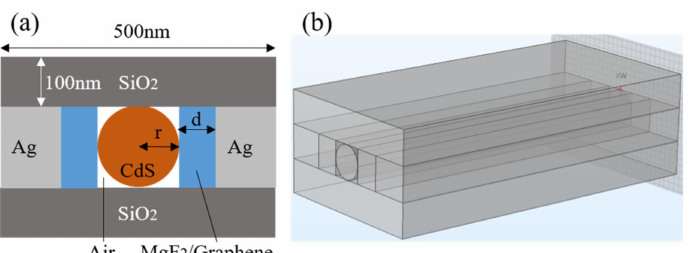
Figure 1. ( a ) The two-dimensional profile and ( b ) the three-dimensional geometry of waveguide model. The structure is composed of CdS gain medium nanowires, an upper SiO 2 layer, a lower SiO 2 layer, left and right medium layers and Ag layers, and an air gap area. Here, the dielectric layer thickness is d and the radius of the CdS nanowires is r . Based on the actual value synthesized in the laboratory and the difficulty of the simulation, the laser length L is set at 10 µ m. The dielectric constants of CdS, MgF 2 , and SiO 2 are 5.76, 1.96, and 2.18, respectively. The dielectric constants of graphene and silver were obtained via Drude model analyses and the calculated values are 2.2 + 4.8i and − 9.2 + 0.3i,